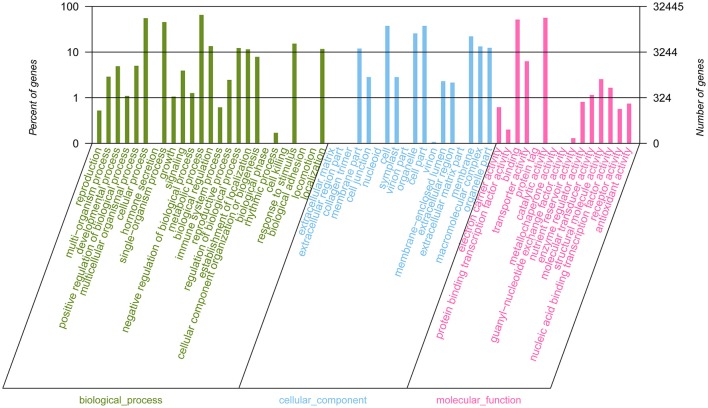
Gene Ontology (GO) functional classification of assembled unigenes. A total of 32,445 unigenes were assigned to at least one GO term and were grouped into three main GO categories and 58 groups, 25 groups in “biological process” domain, 18 in “cellular component” domain, and 15 in “molecular function” domain, respectively. The right-hand and the left-hand y-axis respectively represent the number of genes in a sub-category and the percentage of a specific sub-category of genes in each main category.